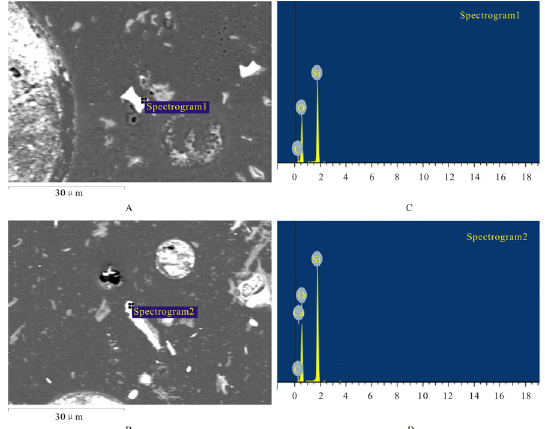
Fig 2. Energy dispersive X-ray analyzer (EDS) analysis revealing constituent elements of phytoliths. Each element is identified by characteristic X-ray peaks of specific energy. A, B, Back-scattered electron imaging (BSE). C, D present C, Si, O in SADDLE and ELONGATE phytolith,